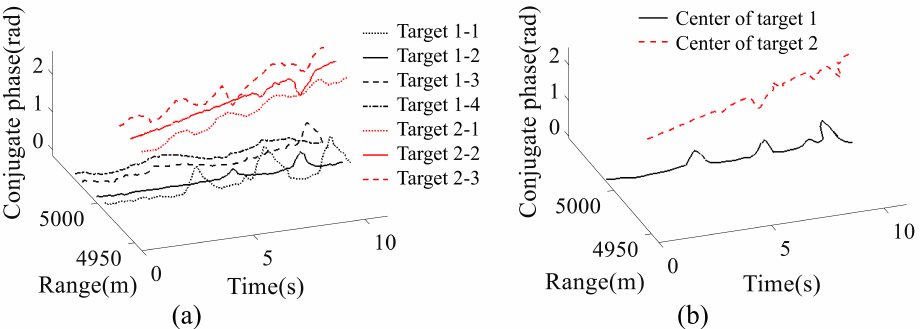
Figure 8. The simulated results of the comparison algorithms. ( a ) The scattering point tracking results of KF-RPRG method. ( b ) The center tracking results of CGT method.